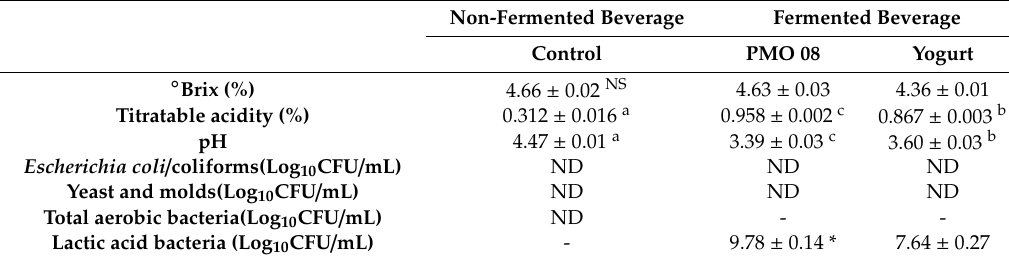
Table 1. Physicochemical and microbial characterization of fermented and non-fermented